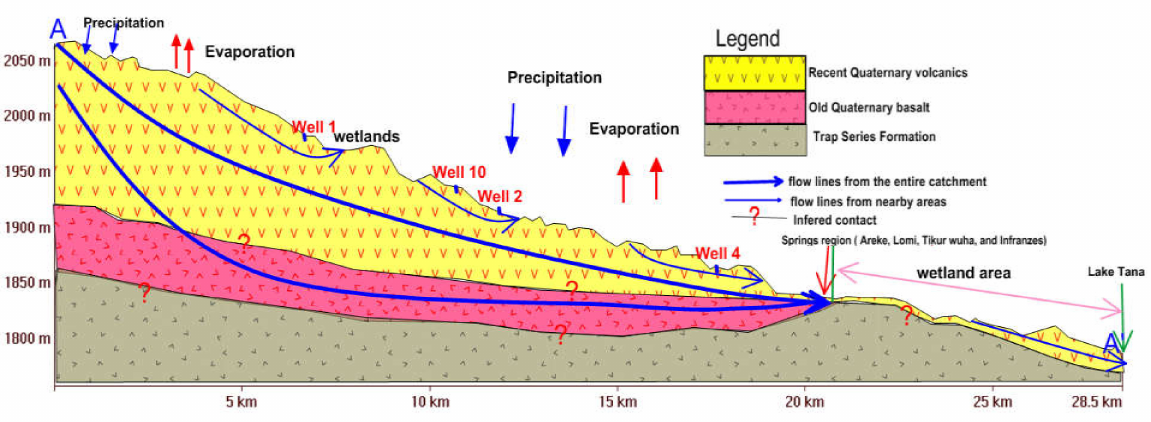
Figure 10. Schematic conceptual model of groundwater flow and circulation in the Infranz catchment, Lake Tana basin (location of cross-section A-A1 in Figure